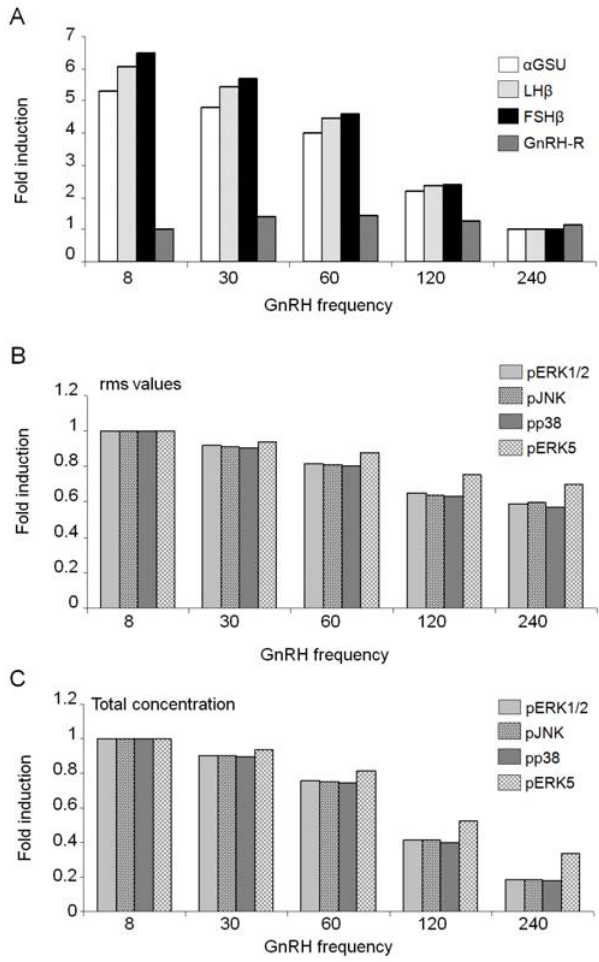
Figure 6. JNK-positive feedforward without ERK5-negative feedback on GnRH-R expression results in loss of differential gene expression. The receptor-enhanced model was simulated for 1440 min. The model was set with e =1 and c =0, so that the system was deprived of the ERK5-negative regulation of the GnRH-R expression levels. Thereafter, (A) expression trends of each subunit and GnRH-R, (B) rms values and (C) total concentration of each pMAPK were plotted.